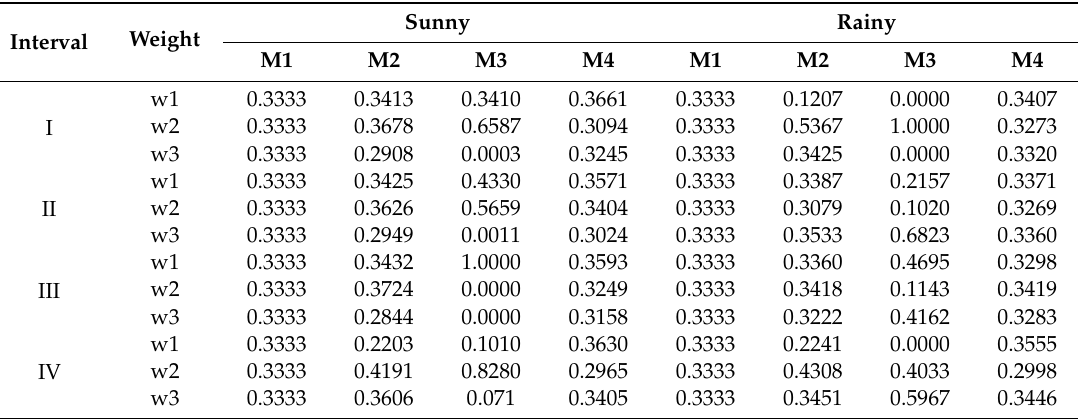
Table 6. Weights of each model in di ff erent